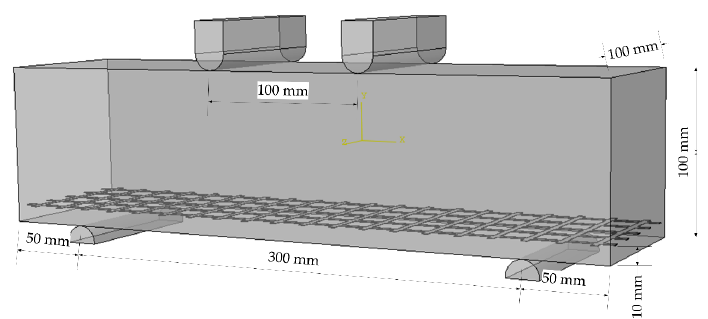
Figure 8. Schematic diagram of the flexural tensile test.